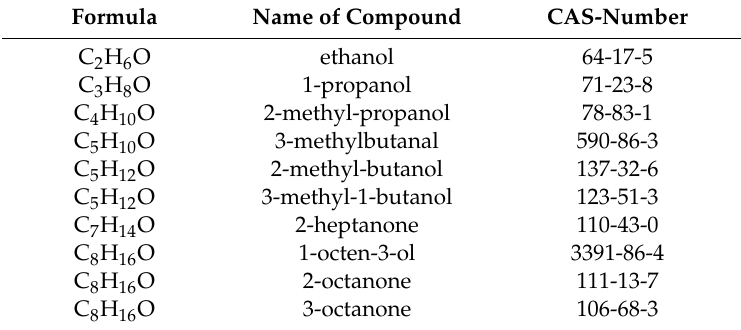
Table 1. Volatile organic compounds (VOCs) identified via gas chromatography–ion mobility spectrometry (GC–IMS) in the headspace of T. atroviride P1 and IMI 206040.